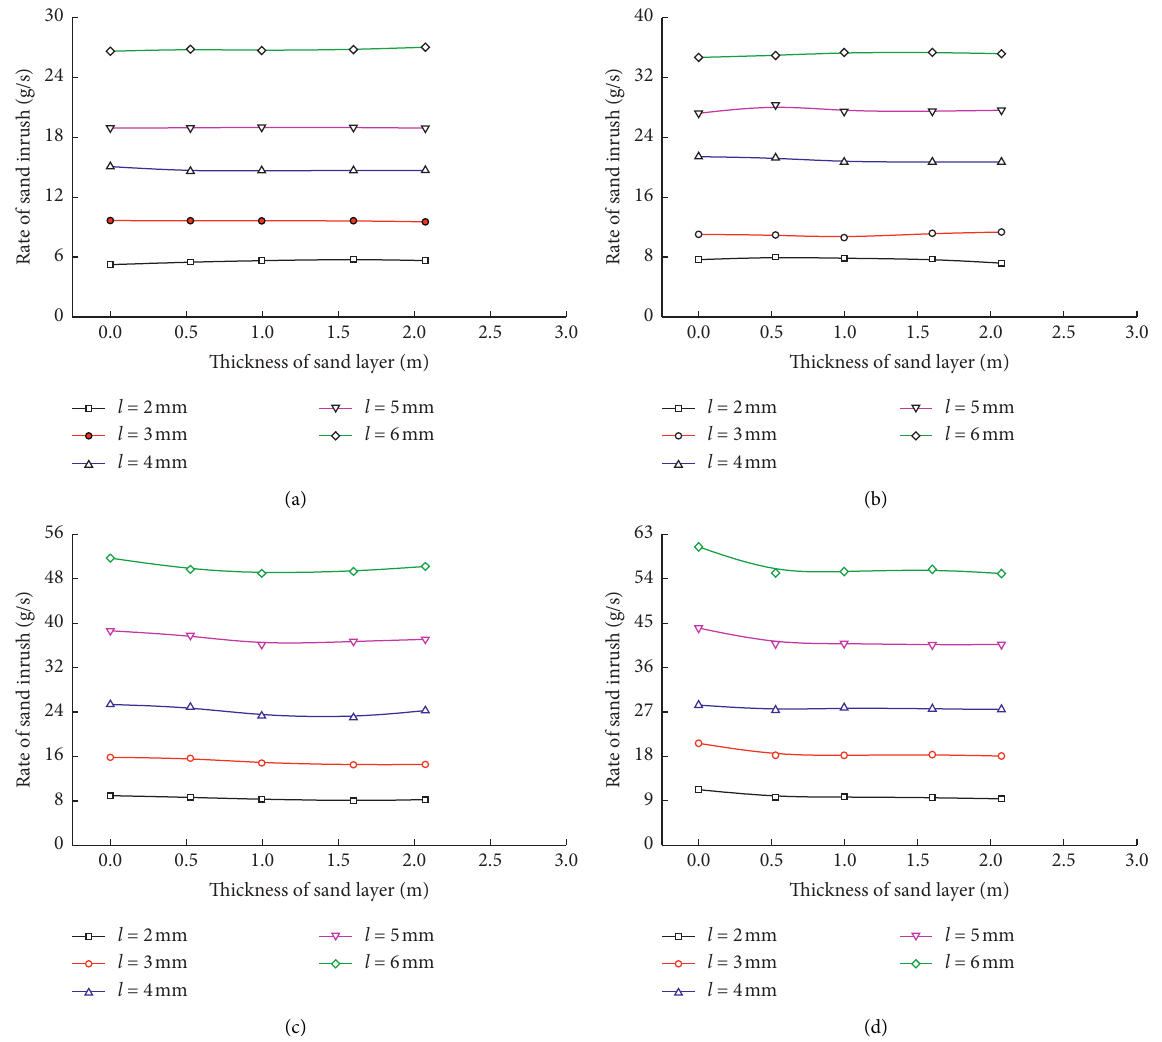
Figure 8: The influence of sand thickness on fracture sand inrush: (a) α � 45 ° , (b) α � 55 ° , (c) α � 65 ° , and (d) α � 90 °